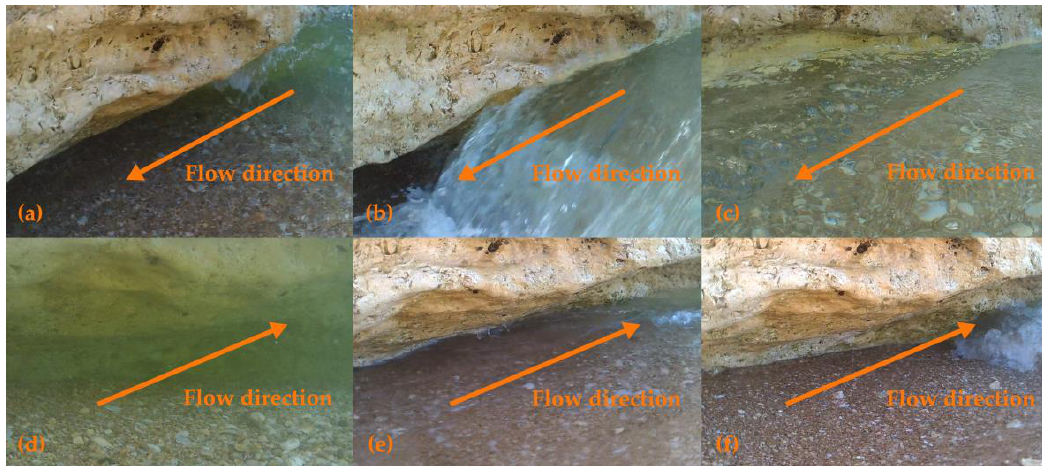
Figure 13. Shuttle flow caused by sea undulation dragging the sediments against the rocky surface causing mechanical erosion. ( a ) Movement of the wave in increasing approach; ( b ) Movement of the wave with breaking; ( c ) Movement of the wave at the maximum point and spreading; ( d ) Beginning of the return movement of the water body; ( e ) Maximum sediment dragging period; and ( f ) Return to the initial position and stabilization until the beginning of a new cycle.